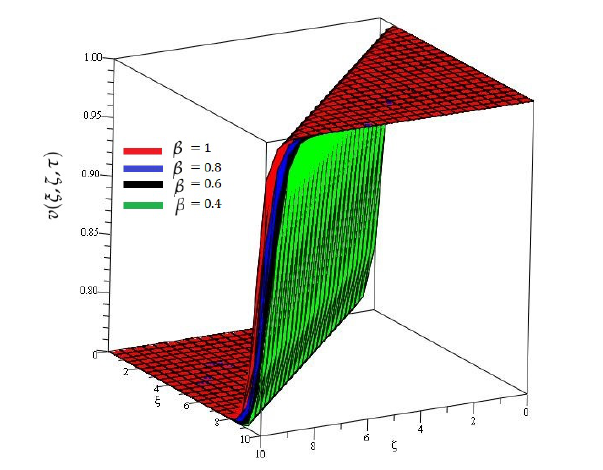
Figure 6. The numerical solution graph of v ( ξ , ζ , τ ) of Example 1 at different value of β .